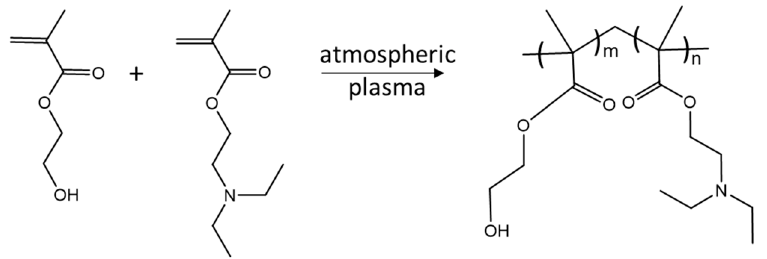
Figure 1. Synthetic route for the plasma polymerization of (p(HEMA-co-DEAEMA) films.